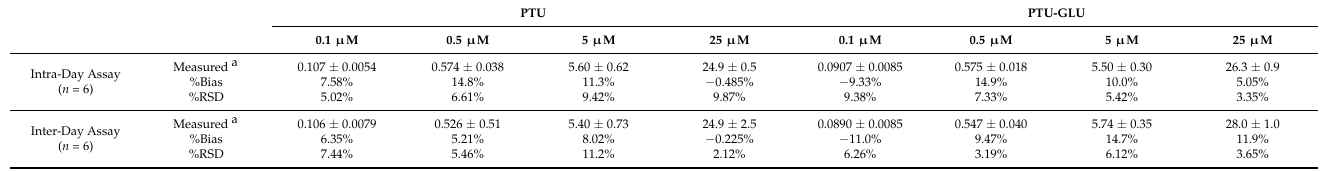
Table 2. Percentage bias and relative standard deviation results of intra- and inter-day assay for PTU and PTU-GLU.